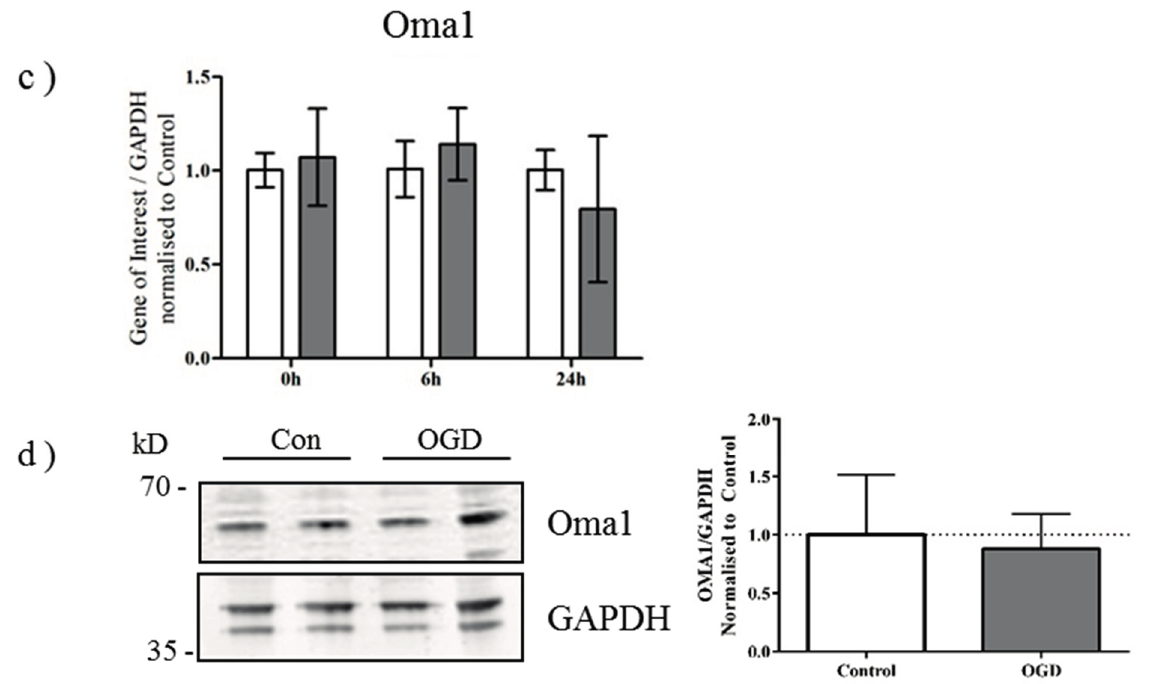
Figure 3. Yme1L protein expression is reduced after OGD ( a ) mRNA generated from control and OGD-treated primary neurons was analyzed by qRT-PCR for changes in expression of Yme1L. Data shown ± SD, n = 3–4 independent litters; ( b ) Protein lysates were generated from primary neurons immediately following OGD and analyzed by western blot for expression of Yme1L. Equal protein loading was determined by GAPDH expression which was used for the quantification (right hand panel). Figure is representative of three individual litters, * p < 0.05 determined by students t -test; ( c ) Oma1 gene expression or ( d ) Oma1 protein expression was determined as above with GAPDH for equal